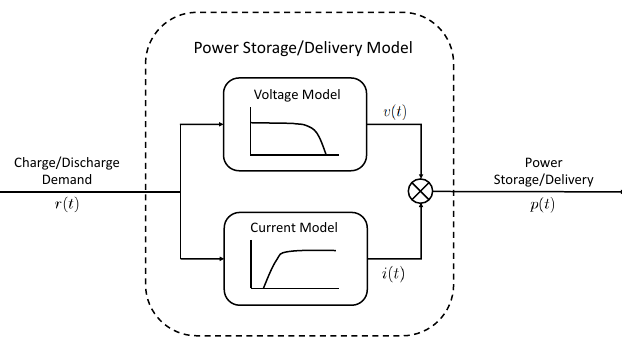
Figure 2. Model approach for dynamic power storage/delivery, see also